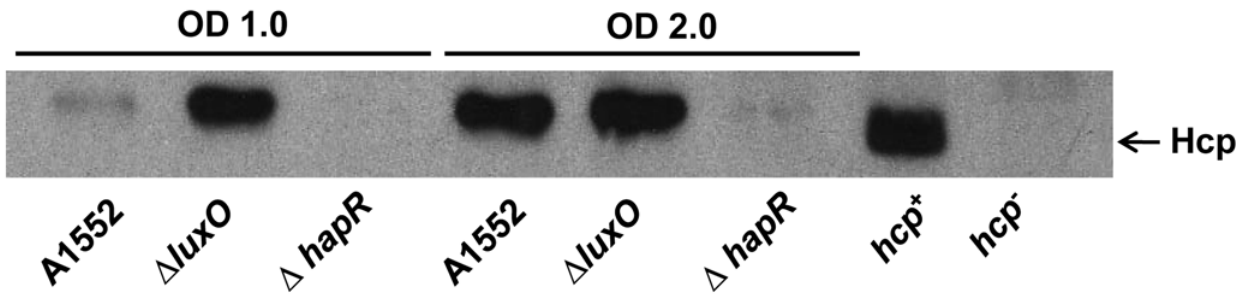
Figure 3. The effect of D hapR and D luxO mutations on Hcp levels in V.cholerae strain A1552. The whole cell lysate samples were taken at OD 1.0 and OD 2.0 and immunoblot analysis was performed using anti-Hcp polyclonal antiserum.